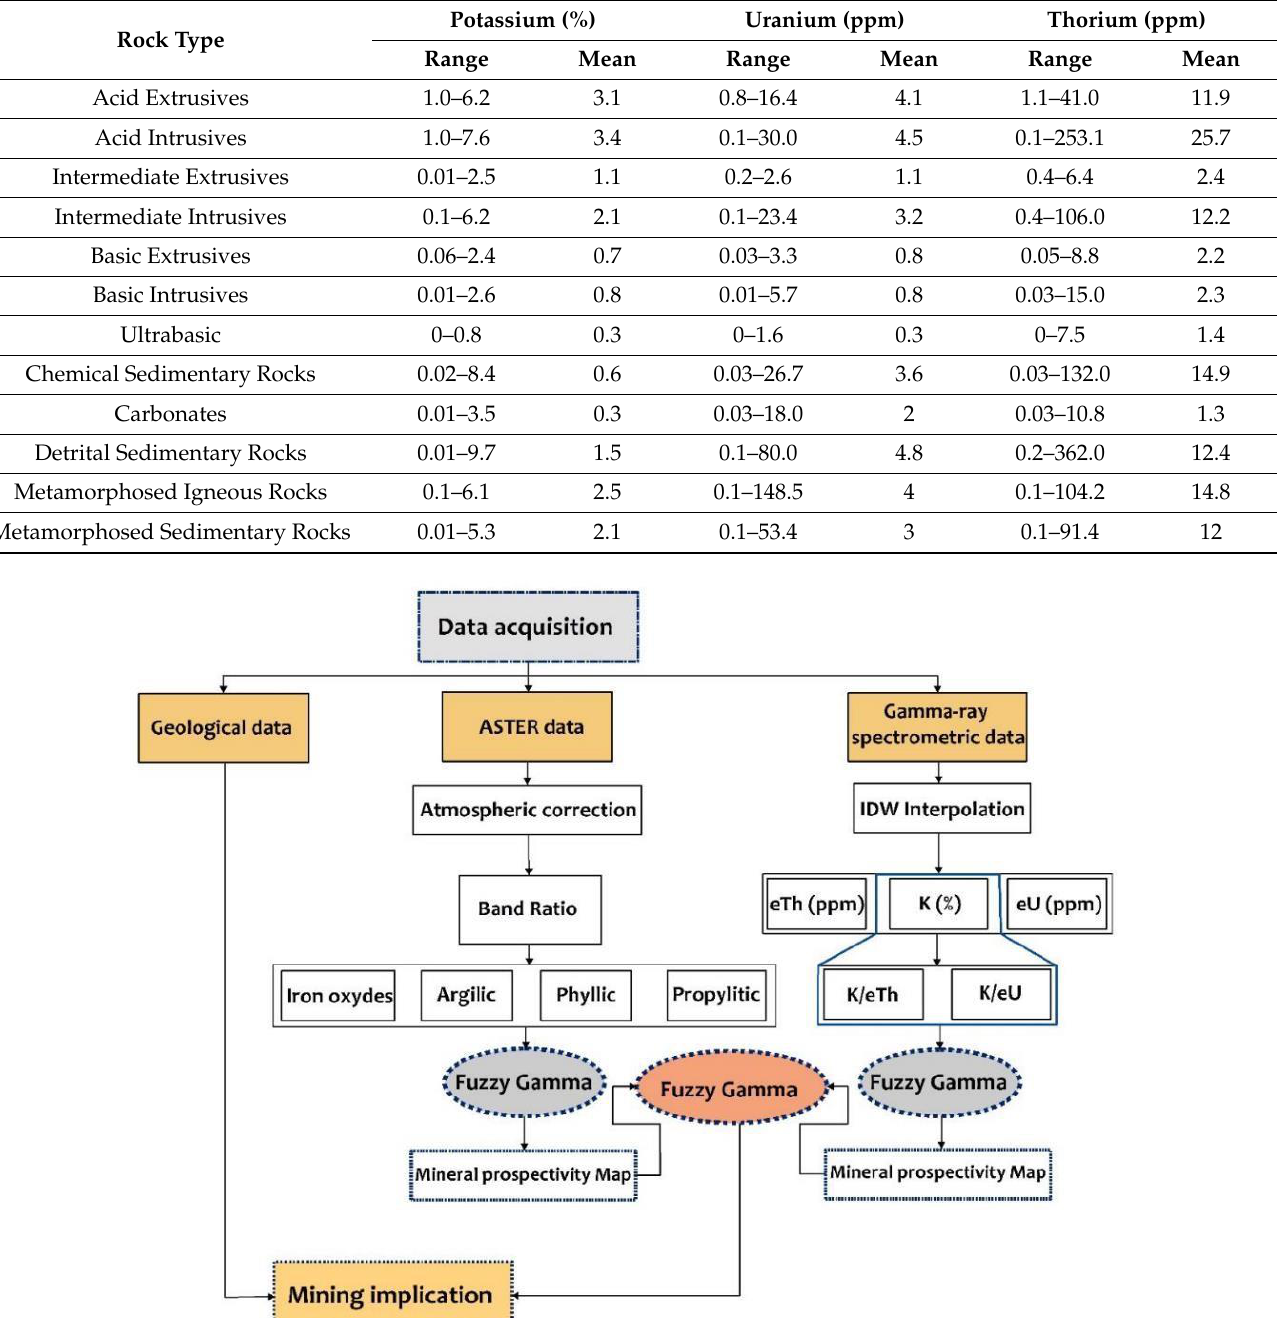
Table 1. Radioelement concentrations in main categories of rocks [53,56].